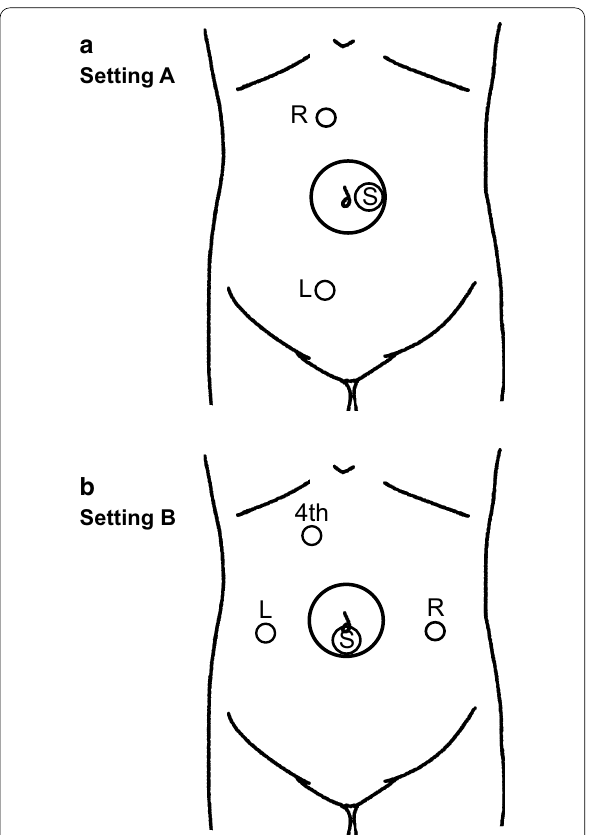
Fig. 1 Port placement of a right hemicolectomy using the Senhance robotic system. a Setting A. Lymphadenectomy and dissection of the ileocolic artery (ICA) and vein (ICV) with mobilization of the right colon and separation of the outer side of the ascending colon from the retroperitoneum was performed using this port placement. b Setting B. Lymphadenectomy and dissection of the middle colic artery (MCA) was performed using this formation. The port for the fourth arm was inserted to expand the transverse mesocolon. Changing the port placement made it easy for the surgeon to identify the MCA by viewing the transverse mesocolon from the front